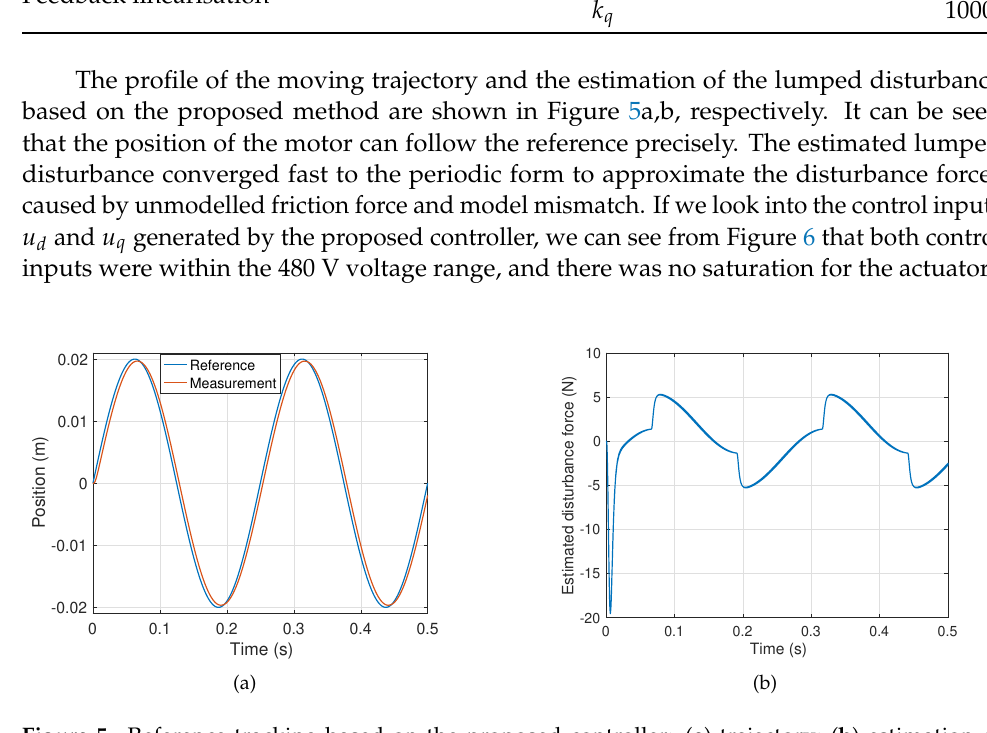
Figure 5. Reference tracking based on the proposed controller: ( a ) trajectory; ( b ) estimation of lumped